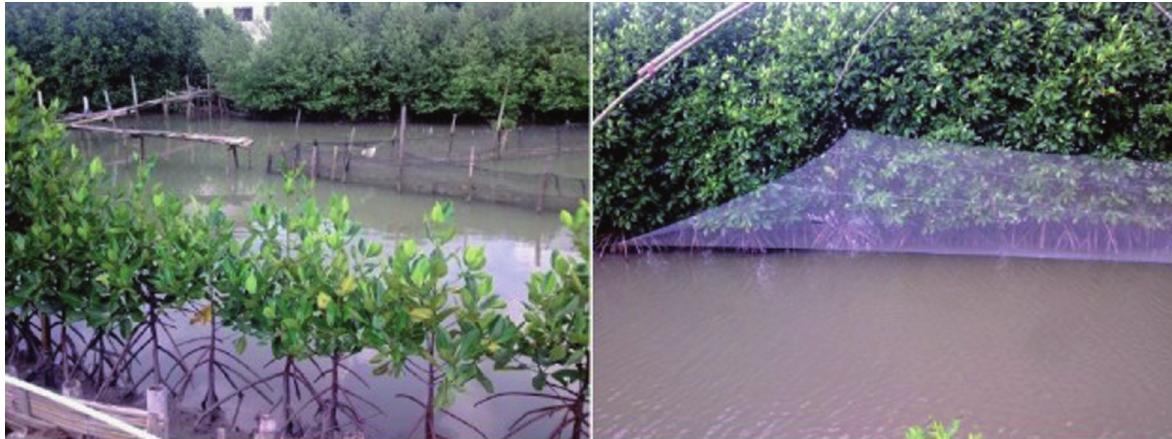
Fig. 5. Fishpond in study